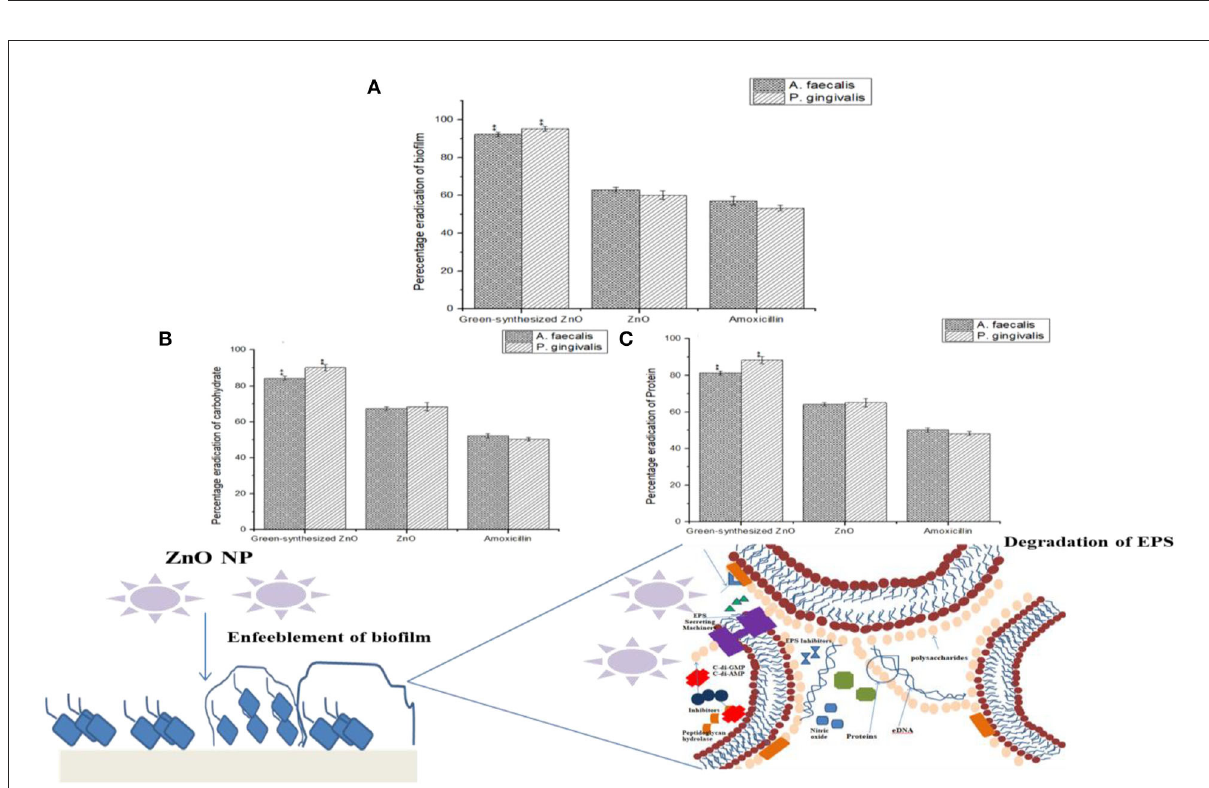
FIGURE7 (A) Reduction of biofilm formed by A. faecalis and P. gingivalis in the presence of green-synthesized ZnO NPs. The ZnO NPs were also responsible for a marked reduction in the EPS with the degradation of (B) the carbohydrate and (C) protein